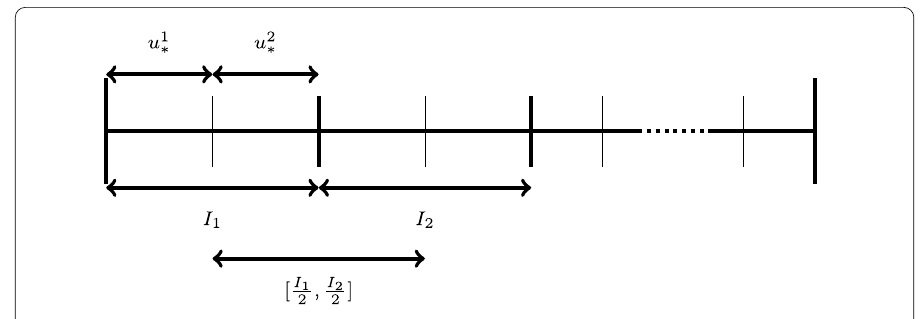
Figure 1 Visualization of the receding horizon procedure. The first iteration computes the optimal control on the interval I 1 . Only the first half of it, u 1 ∗ , is accepted as optimal solution. Then the optimal control on the interval [